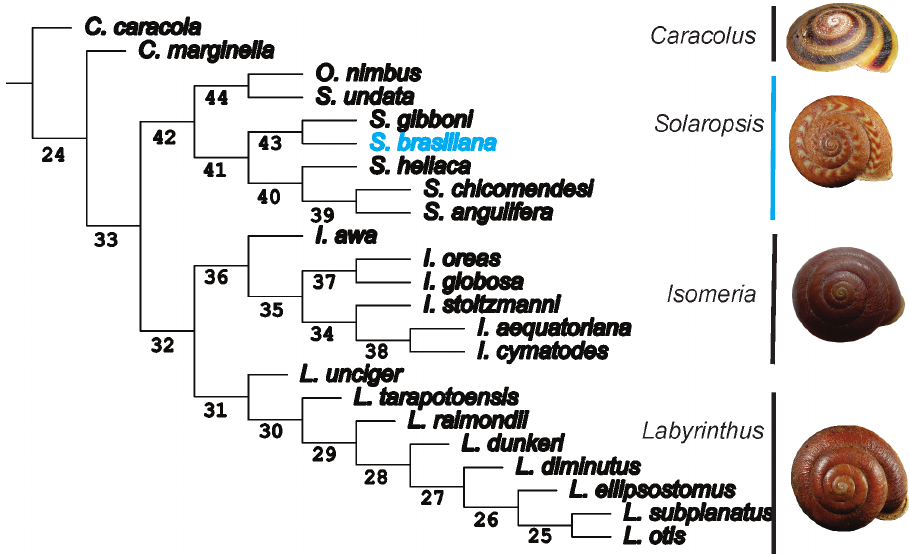
Figure 7 - Single tree obtained in the phylogenetic analysis of the South American Pleurodontidae ( Solaropsis, Isomeria and Labyrinthus ), including species with known anatomy. Tree is rooted in the genus Caracolus , sister group of the remaining species according to Cuezzo (2003). Numbers below branches indicate the nodes of the